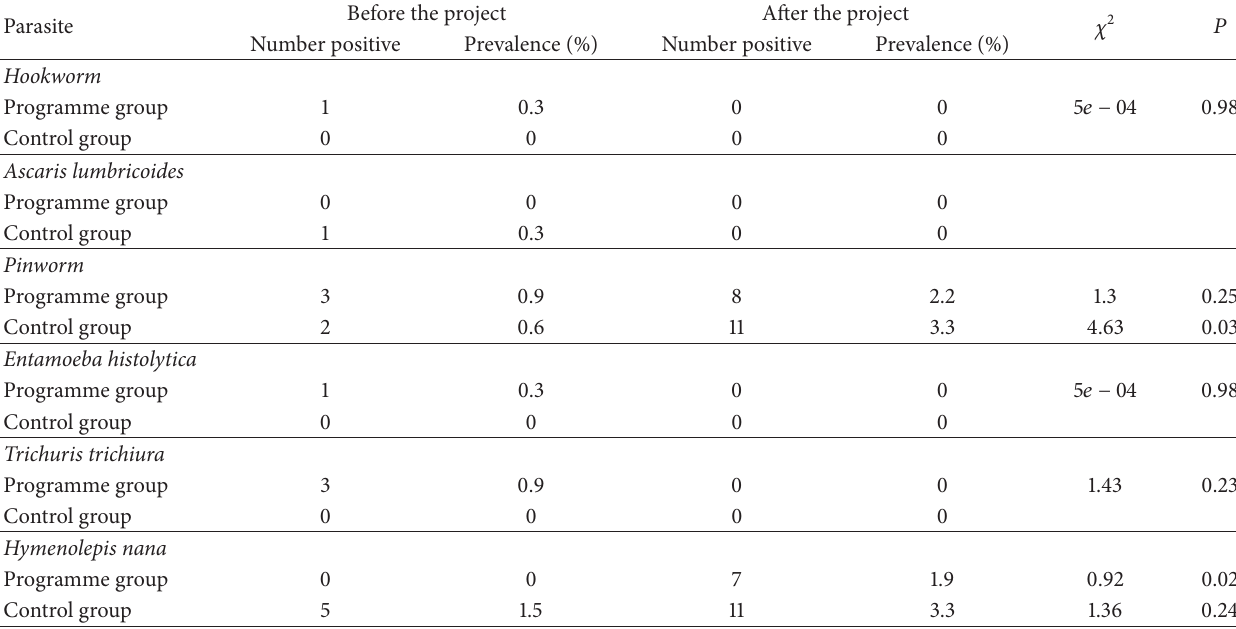
Table 5: Prevalence of parasites found before and after the project in programme schools and control